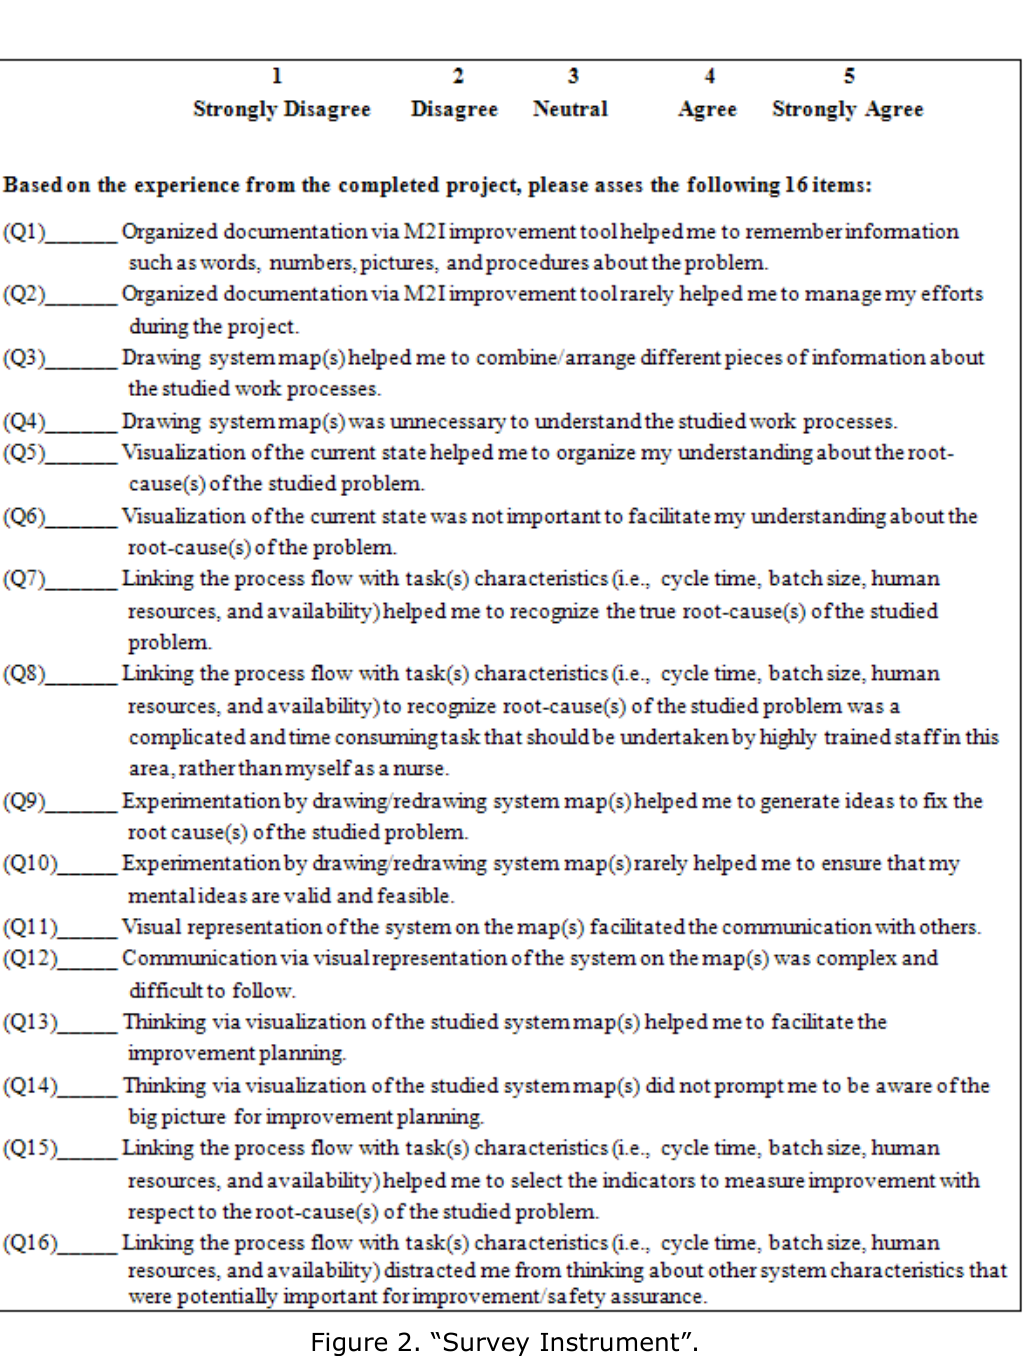
Figure 2. “Survey